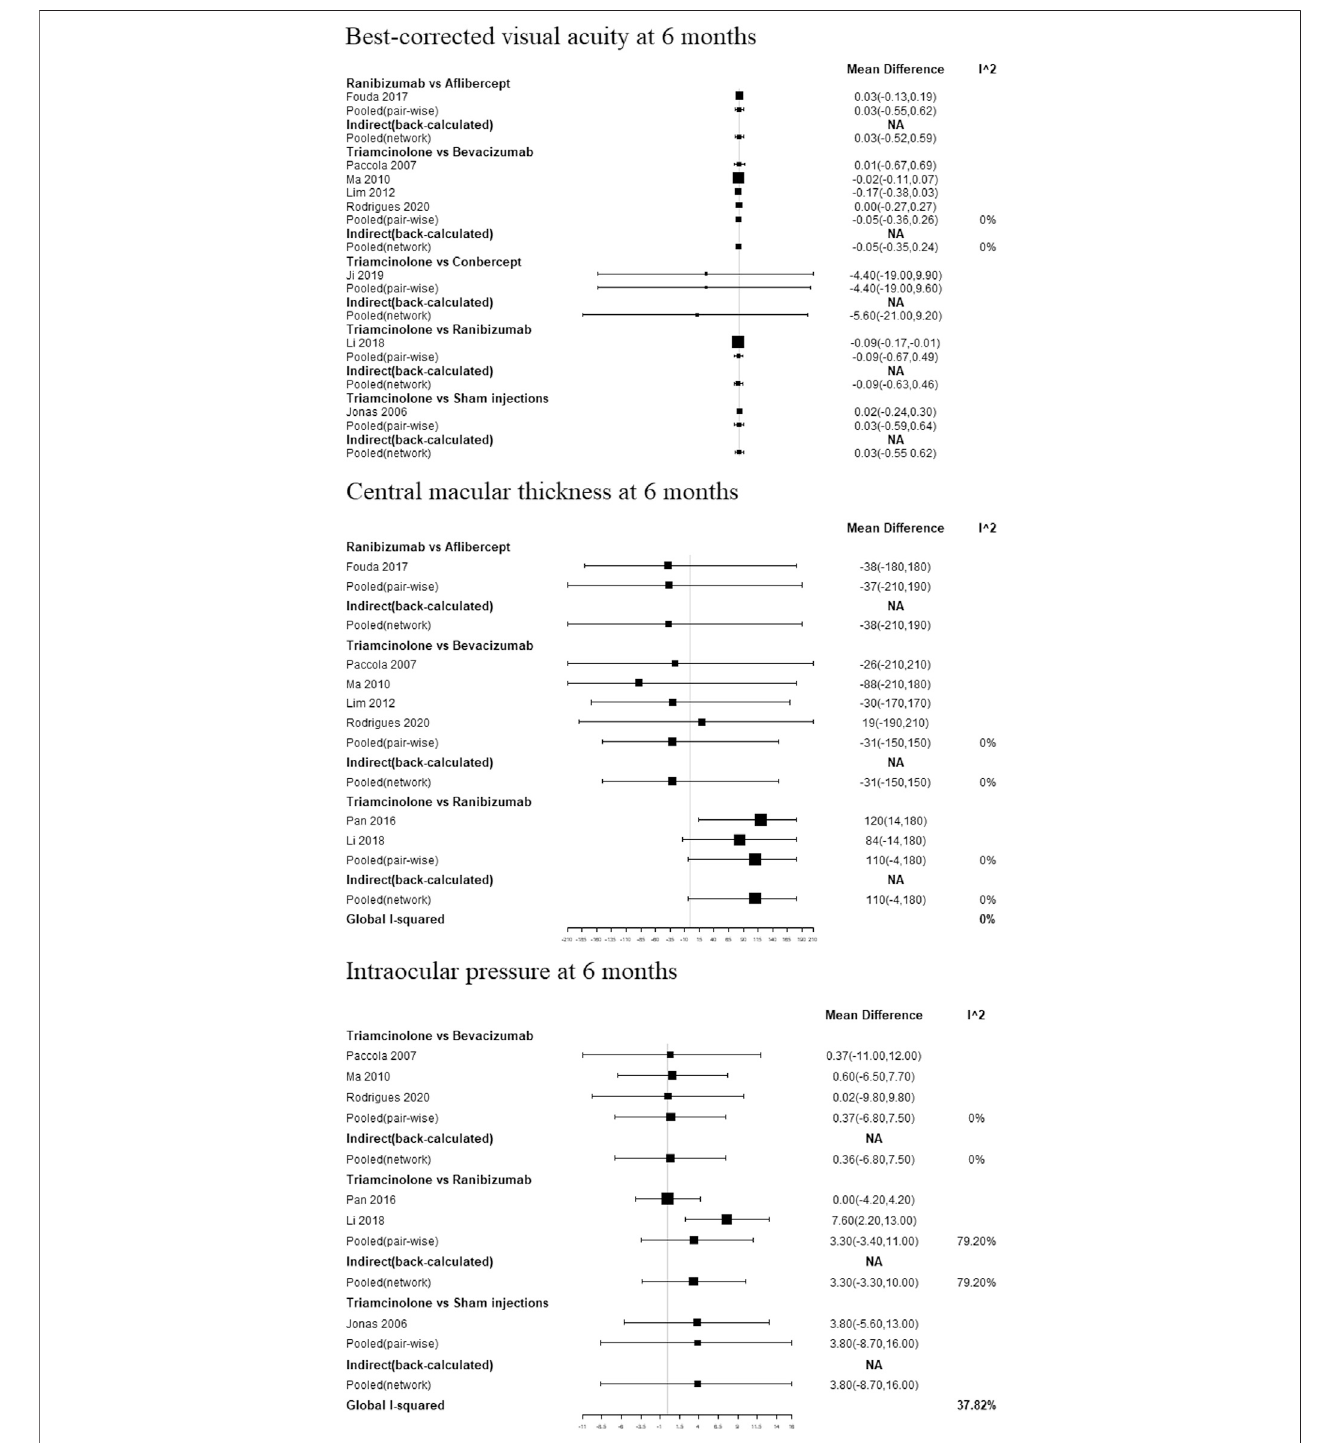
FIGURE 3 | Pair-wise meta-analysis and network meta-analysis of different pharmacological interventions on effect of diabetic macular edema at 6 months.